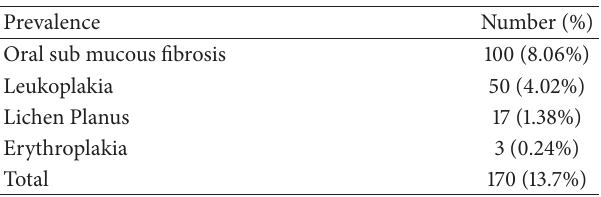
Table 2: Prevalence of oral potentially malignant disorders in the study